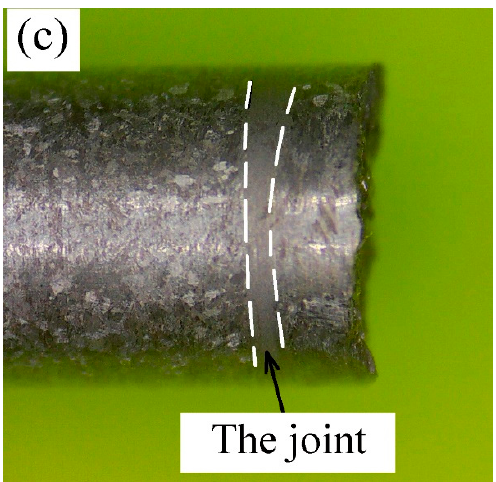
Figure 11. Photographs of the fractured tensile specimens: ( a ) all specimens; ( b ) the left half of CJ2; ( c ) close-up of the joint.